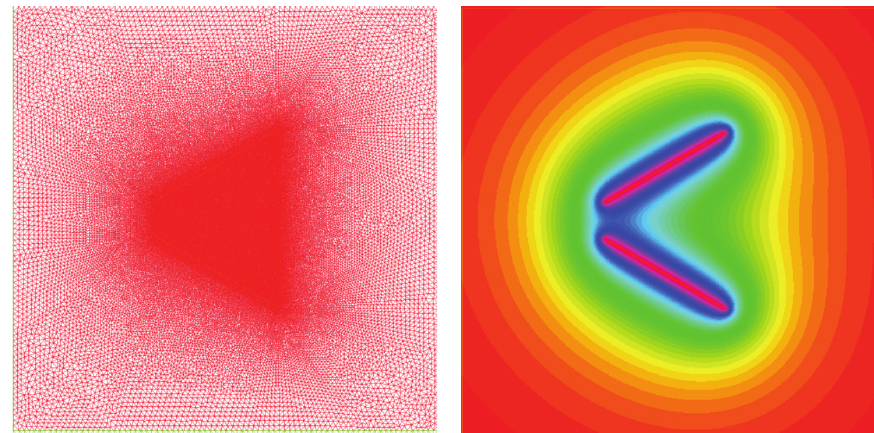
Figure 1: Finite element mesh and corresponding potential nephogram.